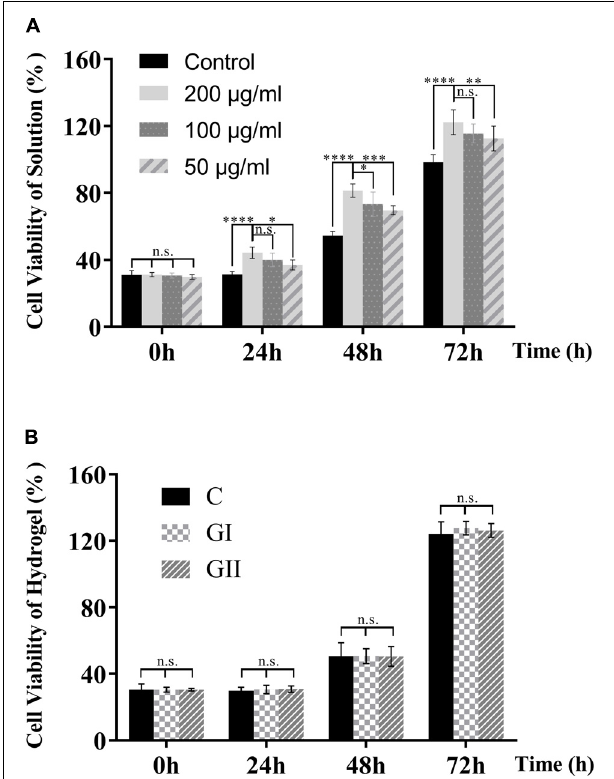
FIGURE 5 | Cytotoxicity of the CuS NPs and CuS/HA hydrogel. (A) The cytotoxicity of the CuS NPs solutions with different concentrations. (B) The cytotoxicity of the hydrogels (G I and G II) compared with the blank control. Error bars represent means ± SD for n = 5, ****for P < 0.0001, ***for P < 0.001, ** for P < 0.01, and *for P <